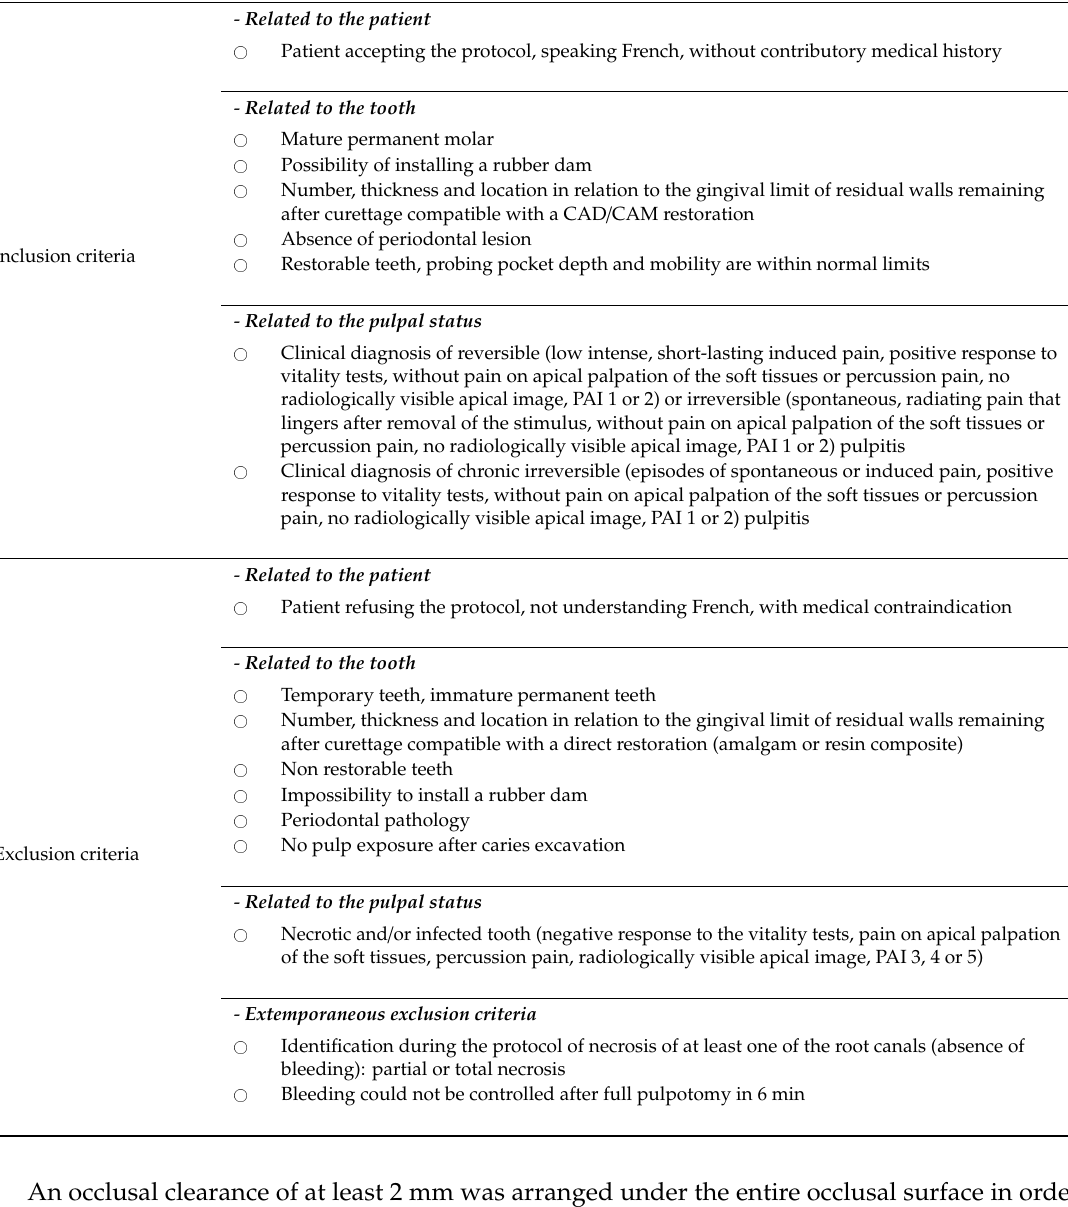
Table 1. Inclusion and exclusion